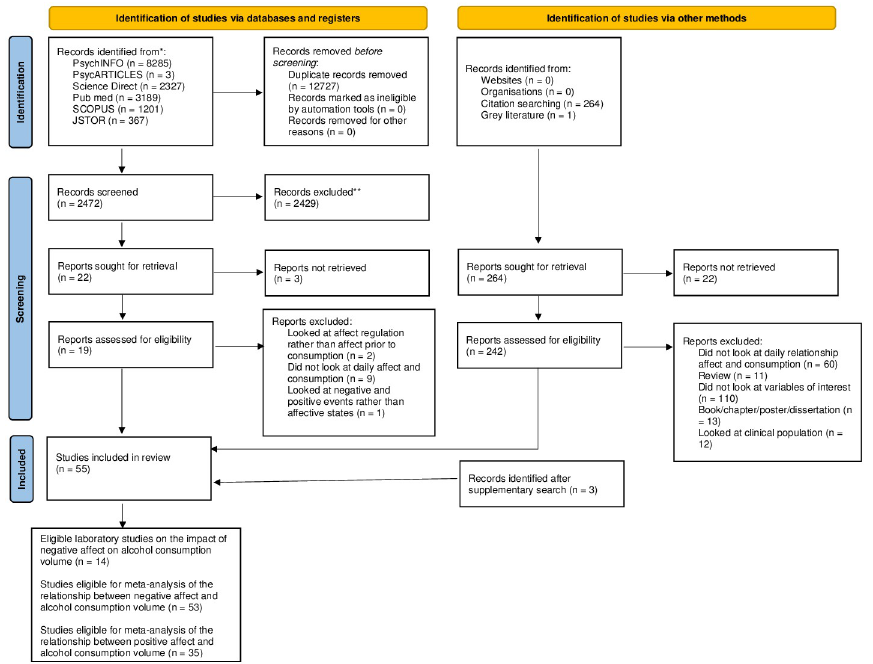
Fig 1. Flowchart of study selection